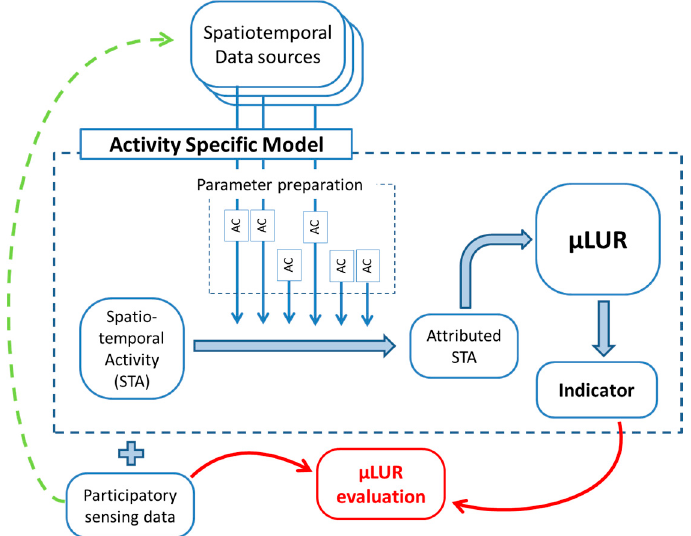
Figure 1. The activity specific model combines the spatiotemporal attribution of the activity and the µLUR model. The activity calculations (AC) convert the external data to activity specific attributes (blue arrows). The red arrows represent the µLUR validation process. The ubiquitous information gathered in parallel with the indicator can be used as external data (dashed green arrow).